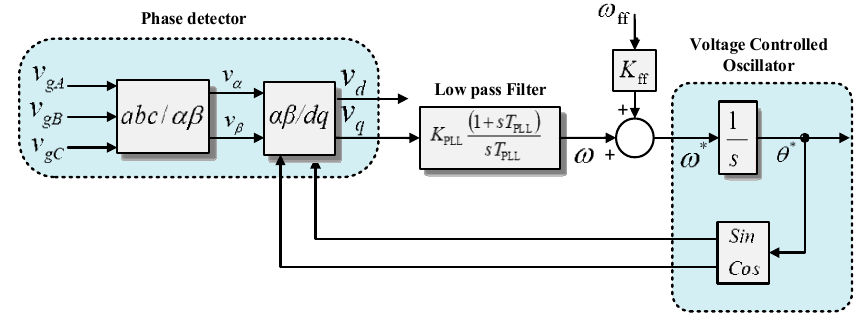
Figure 2. Basic Synchronous Reference Frame based PLL structure.